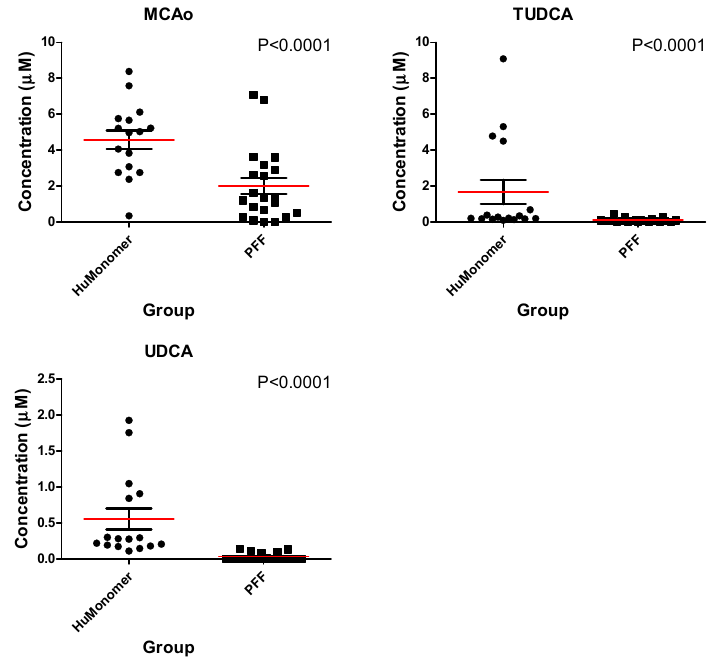
Figure 1. The mean distribution ( ± SEM) for each of the three significantly different bile acids between mice injected with HuMonomers and PFFs.